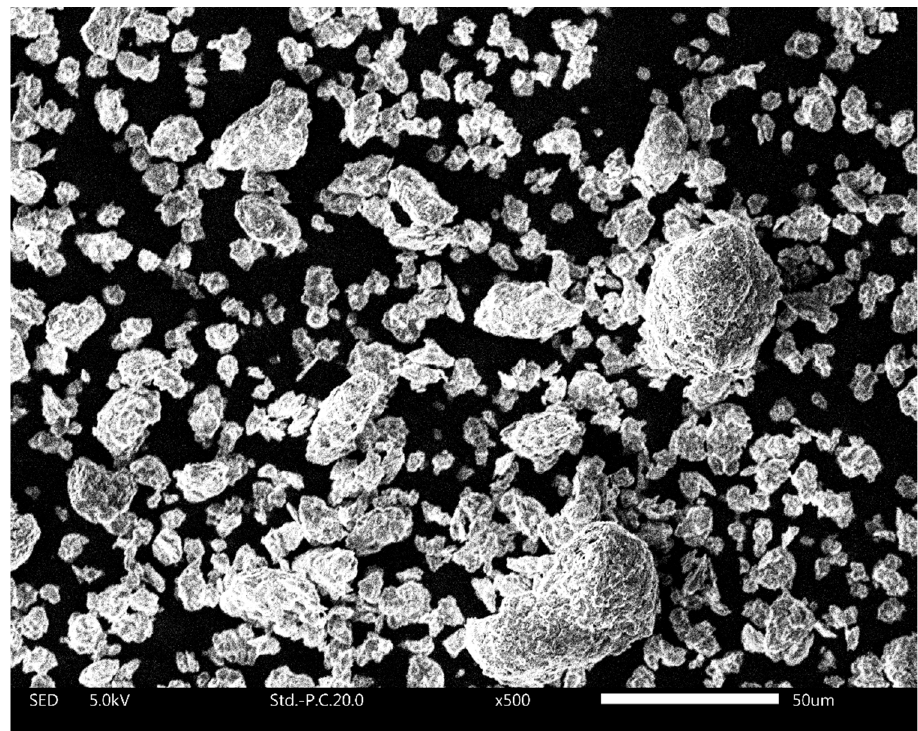
Figure 10. Scanning electron microscopy image of calcined clay particles used in this study.